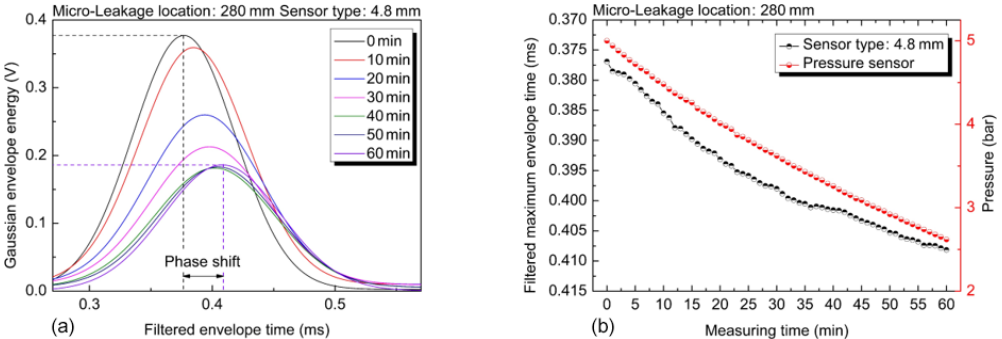
Figure 6. Phase shift of ultrasonic sensor envelope signal filtered through a Gaussian distribution for micro-leakage location of